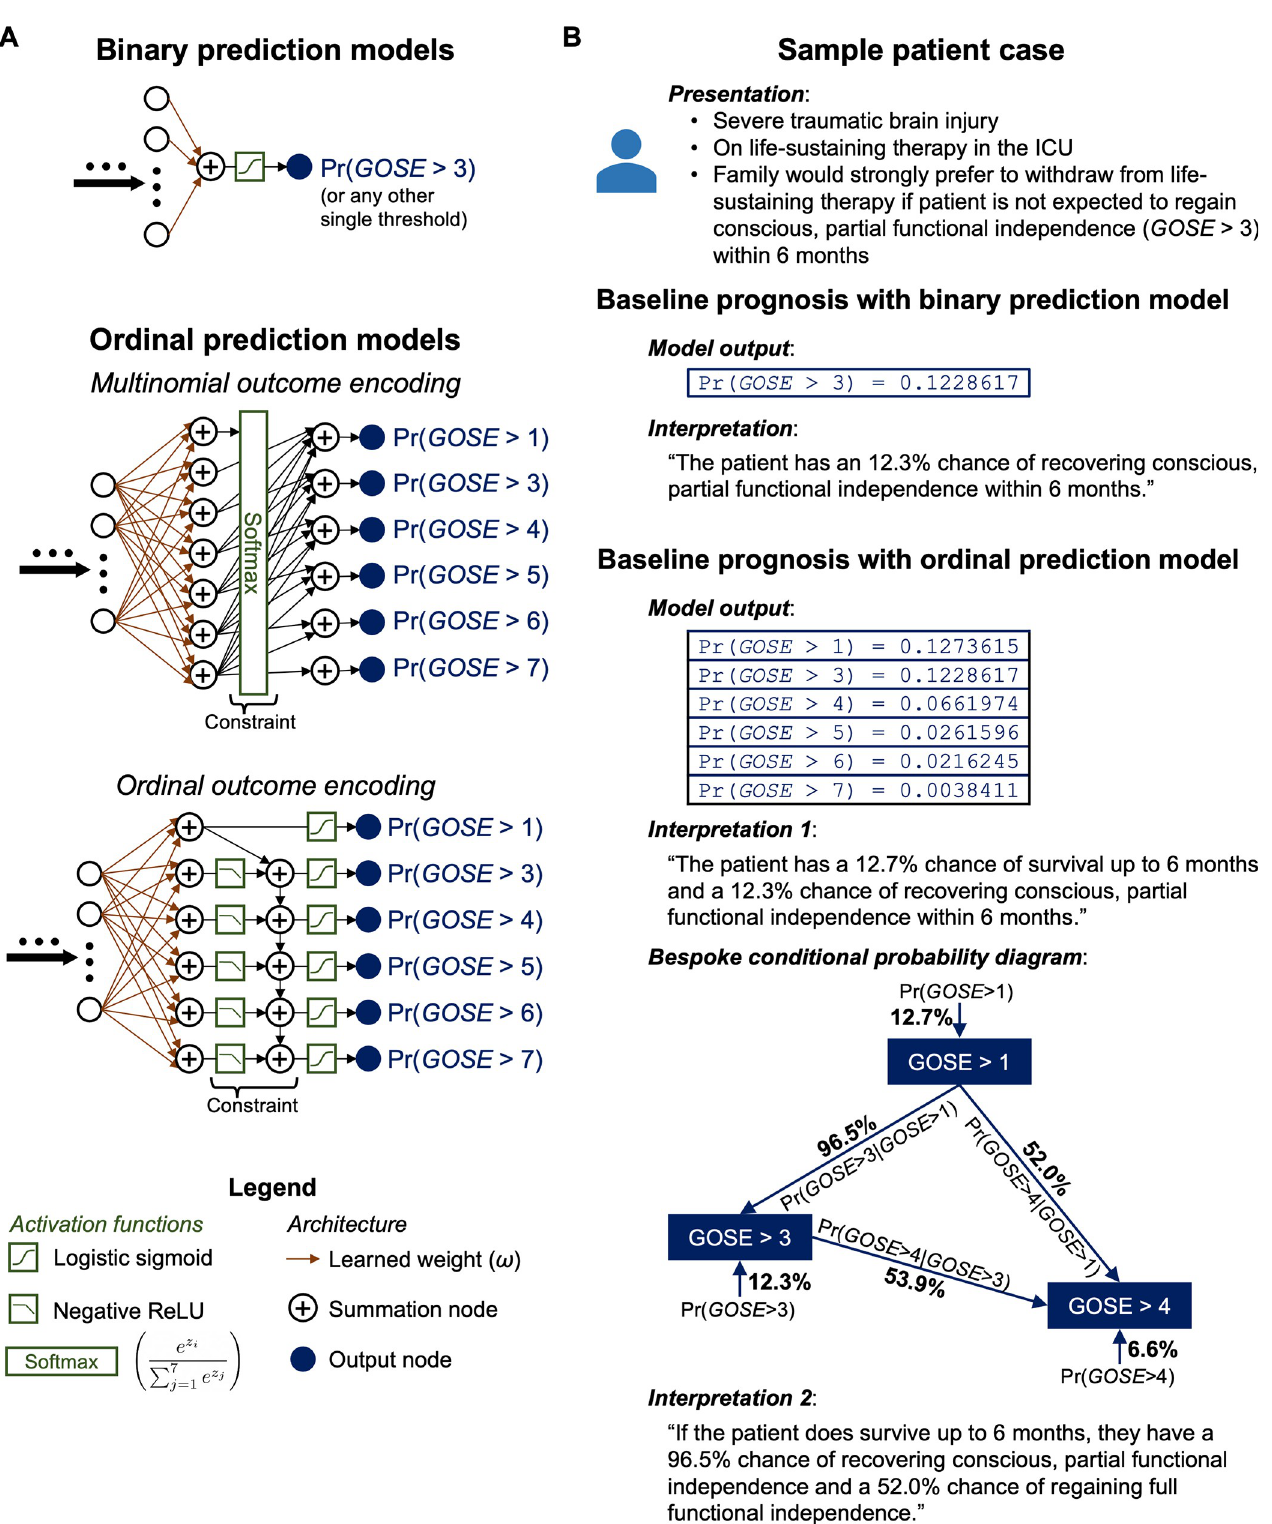
Fig 1. Comparison of ordinal outcome prediction to binary outcome prediction in terms of model architecture and clinical application. GOSE = Glasgow Outcome Scale–Extended at 6 months post-injury. ReLU = rectified linear unit. Pr(•) = Probability operator, i.e., “probability of •.” Pr(•| � ) = Conditional probability operator, i.e., “probability of •, given � .” ( A ) Output layer architectures of binary and ordinal GOSE prediction models. Ordinal prediction models